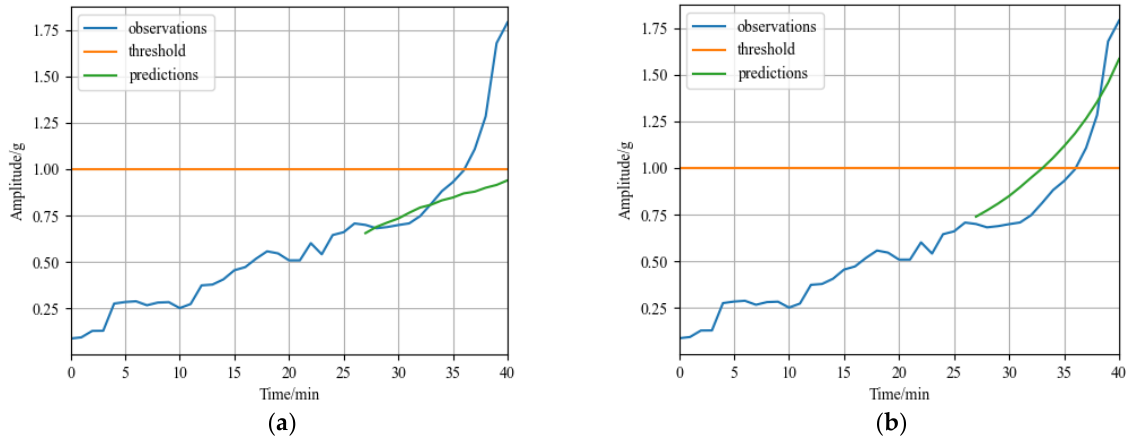
Figure 12. Comparative experiment results of bearing2_1 in XJTU-SY dataset: ( a ) RUL prediction result of CNN model; ( b ) RUL prediction result of LSTM model.